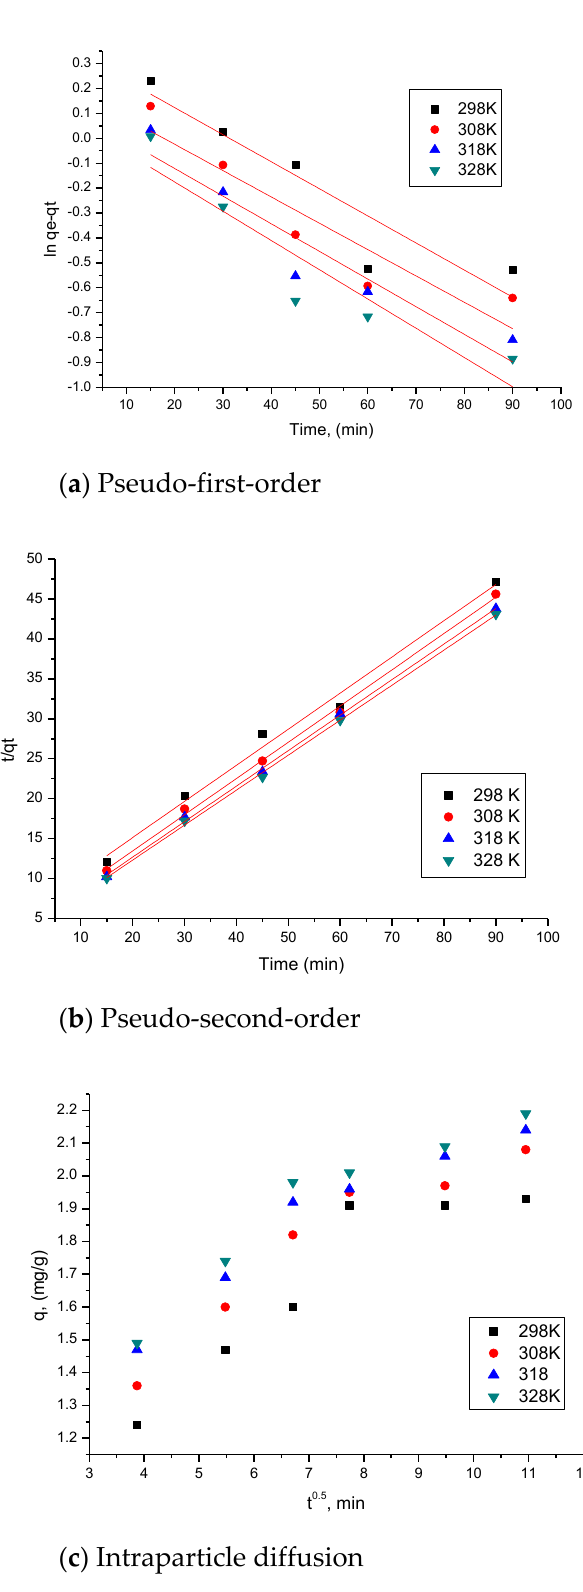
Figure 5. Kinetic studies. The values of rate constants, k, adsorption capacity, as well as for K diff and C parameters from the modelling, are shown in Table 3. Also shown in the same table are the values of the regression coefficient, R 2 .